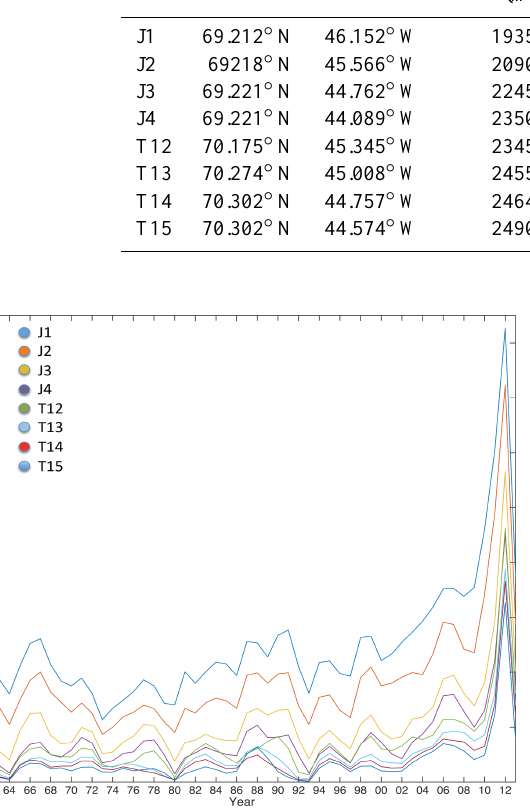
Figure 6. 1958–2013 modeled annual melt rates from RACMO2.3/GR for each field site visited between 2011 and